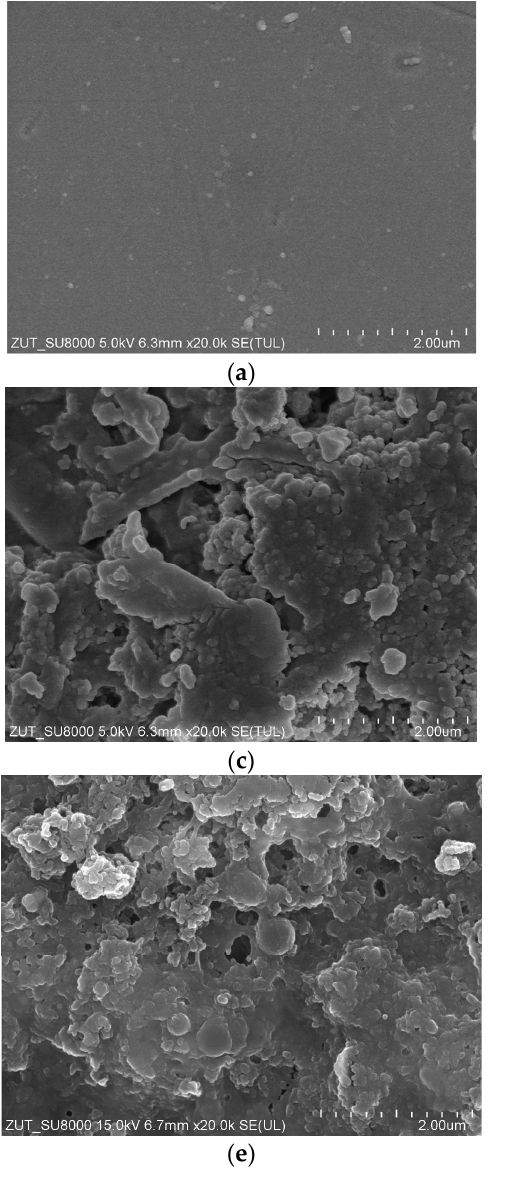
Figure 16. FESEM images of the membranes’ surface: ( a ) Virgin UE10; ( b ) Virgin UE50; ( c ) UE10 with deposits after separation of the blue+wax solution; ( d ) UE50 with deposits after separation of the blue+wax solution; ( e ) UE10 with deposits after separation of the real wastewater; ( f ) UE50 with deposits after separation of real wastewater.